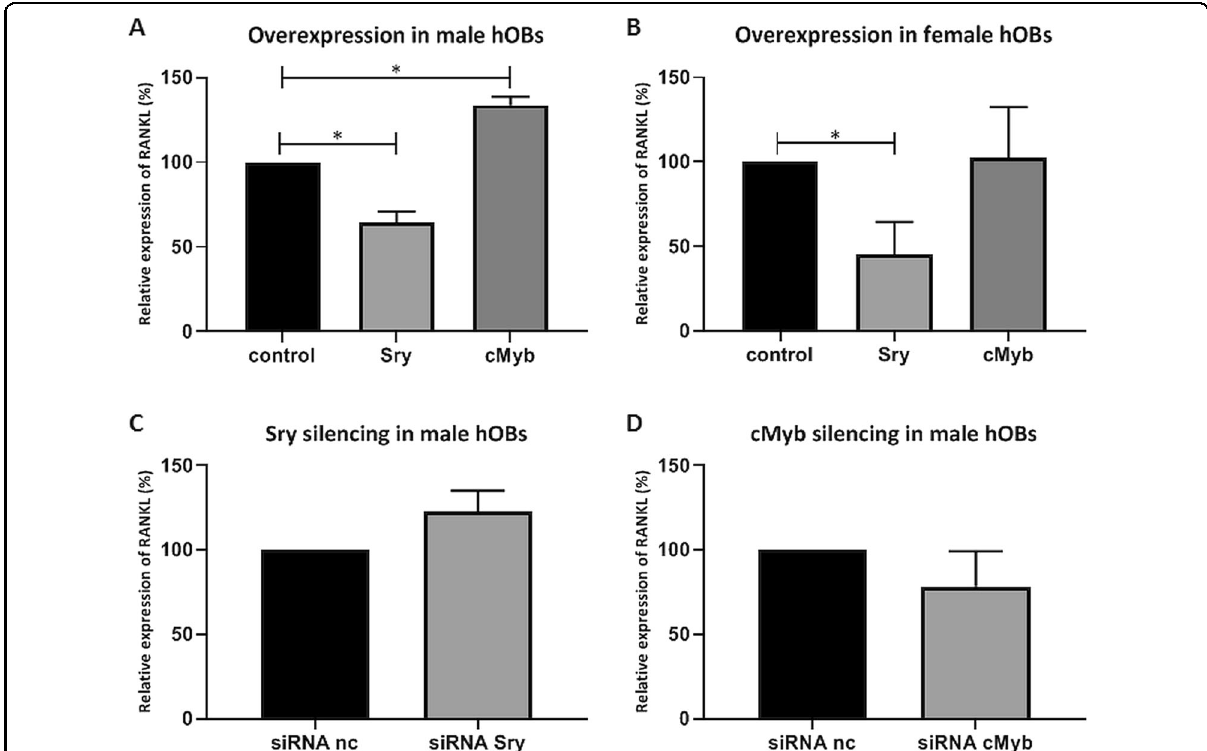
Fig. 3 c-Myb and SRY affect the expression of the RANKL gene in human primary osteoblasts. a , b Female ( a ) and male ( b ) human primary osteoblasts were transfected with empty expression vector (ctl) and Sry-FLAG or c-Myb-HA. RANKL gene expression was measured at 48 h after treatment using q-PCR. c , d Male human primary osteoblasts were nucleofected with negative control siRNA and siRNAs against c-Myb ( c ) or Sry ( d ). RANKL gene expression was measured at 72 h after treatment using q-PCR. All of the data are presented as the mean relative RANKL expression after normalization ± SEM. Asterisks indicate signi fi cant differences between two samples. Data are representative of at least three independent